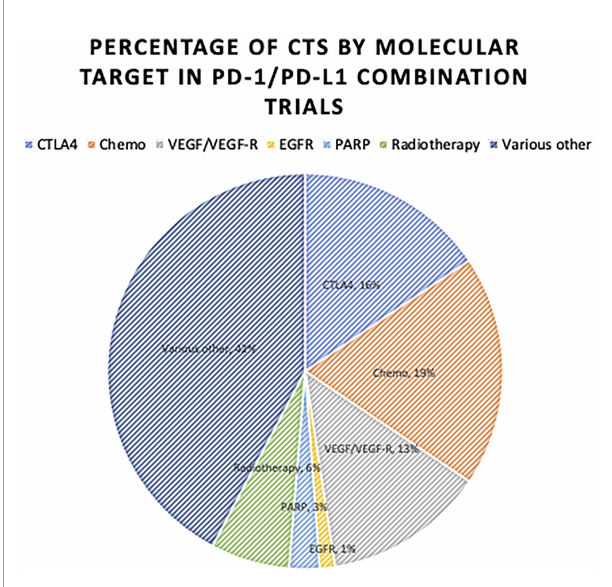
FIGURE 3 | Proportion of Combination RCTs for PD-1/PD-L1 Combination Therapy by Target Studied. Proportion of current RCTs studying other targets in combination with PD-1/PD-L1 agents. IO, Immuno-Oncologic Therapy; RCT, Randomized Control Trial; ICI, Immune-checkpoint Inhibitor; CTLA-4, Cytotoxic T-Lymphocyte Antigen-4; PD-1, Programmed Death Receptor-1; PD-L1, Programmed Death Receptor Ligand-1; VEGF/VEGF-R, Vascular Endothelial Growth Factor/-Receptor; EGFR, Epidermal Growth Factor Receptor; Chemo, Chemotherapy; PARP, Poly ADP Ribose Polymerase. Various Other, Includes a large array of additional targets. Only signi fi cant combination targets were